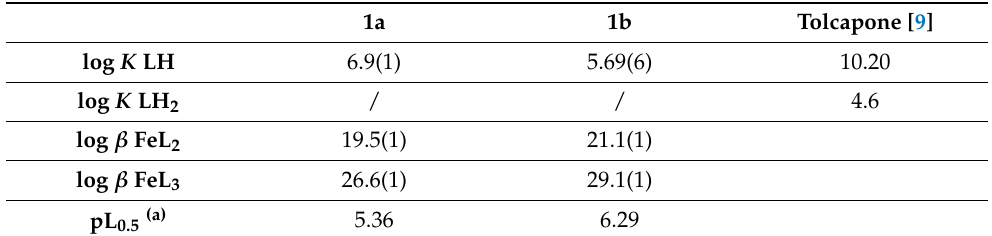
Table 1. Protonation constants (log K ) of ligands and overall stability constants (log β ) of their Fe(III) complexes. Solvent: MeOH/H 2 O 80/20 w / w ), I = 0.1 M (NaClO 4 ), T = 25.0 ◦